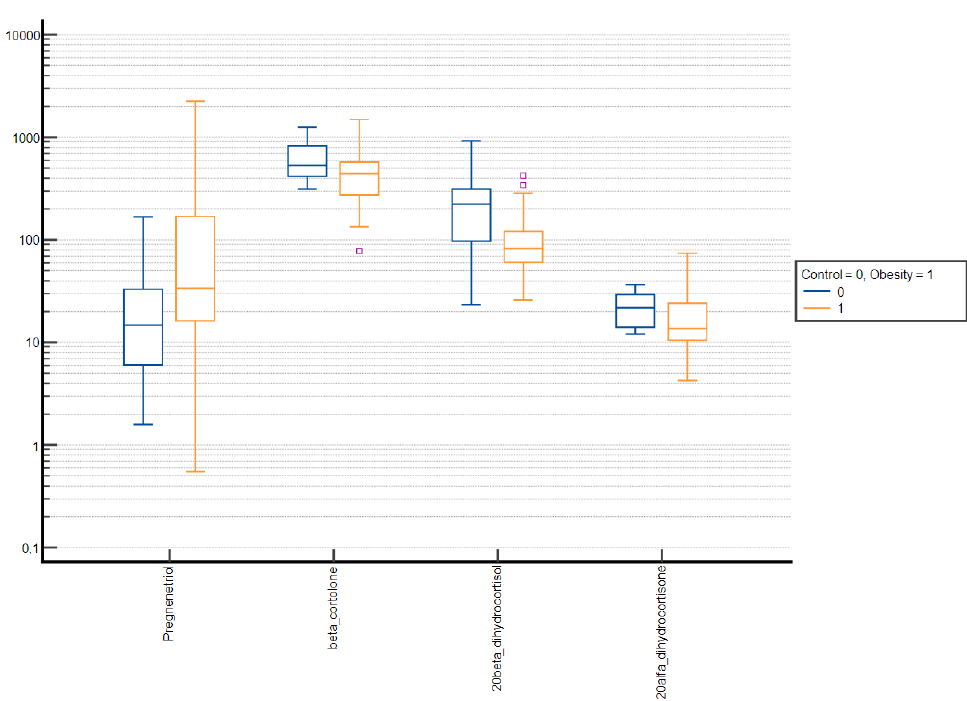
Figure 5. Comparative box plots of steroid metabolites with statistically significant difference ( p -value < 0.05) between the normal weight and obesity girls in the advanced puberty group. A loga- rithmic scale was used. Exact results are available in Supplementary Table S4. Purple square – out- liers.